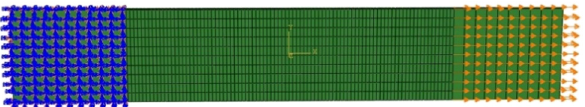
Figure 7: FEA model of cord –